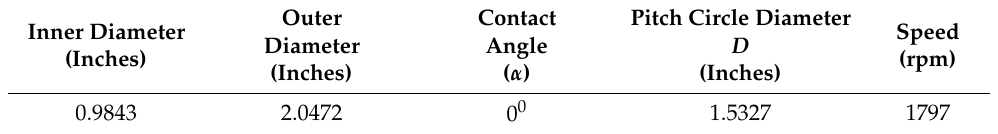
Figure 20. Illustration of the bearing experimental platform and rolling bearing. ( a )Illustration of the bearing experimental platform. ( b ) Rolling bearing. Table 6. The bearing structure